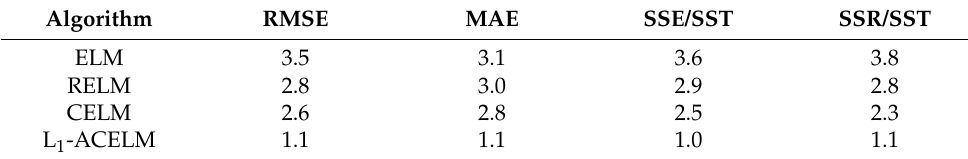
Table 9. Average ranks of benchmark algorithms under 10% noise environment.